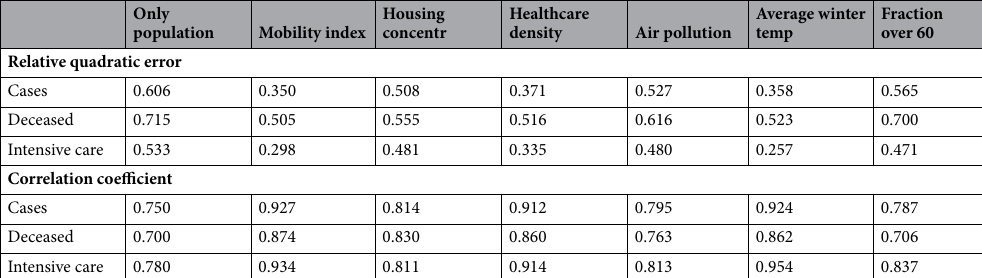
Table 3. Relative mean quadratic error and correlation coefficient of single parameters.